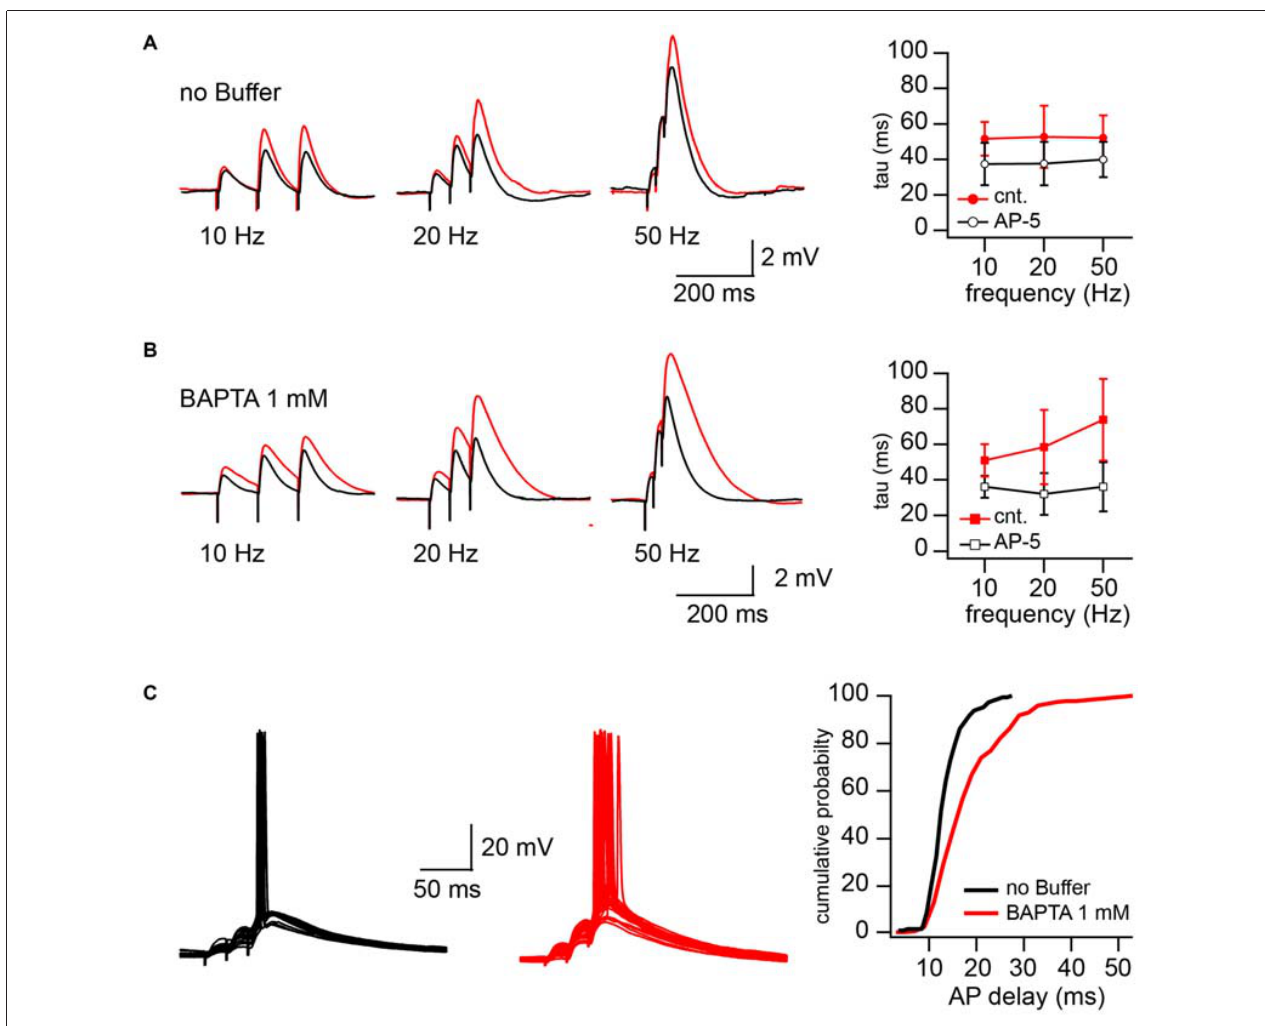
FIGURE 4 | CIIN significantly accelerates decay of EPSPs and shortens the time window for action potential (AP) generation. (A) EPSPs evoked by 10, 20, and 50 Hz trains in cells patched with buffer-free intracellular solution in the presence (black) and absence (red) of 50 µ M APV. The plot shows the effect of NMDAR blockade on the decay time constant of the last response at different stimulation frequencies. (B) The same as in (A) , obtained from the neurons loaded with 1 mM BAPTA. (C) Synaptically evoked APs recorded with buffer-free (black) and BAPTA-containing (red) pipette solutions. The plot represents the dependence of AP delays (latencies) on the cellular buffer